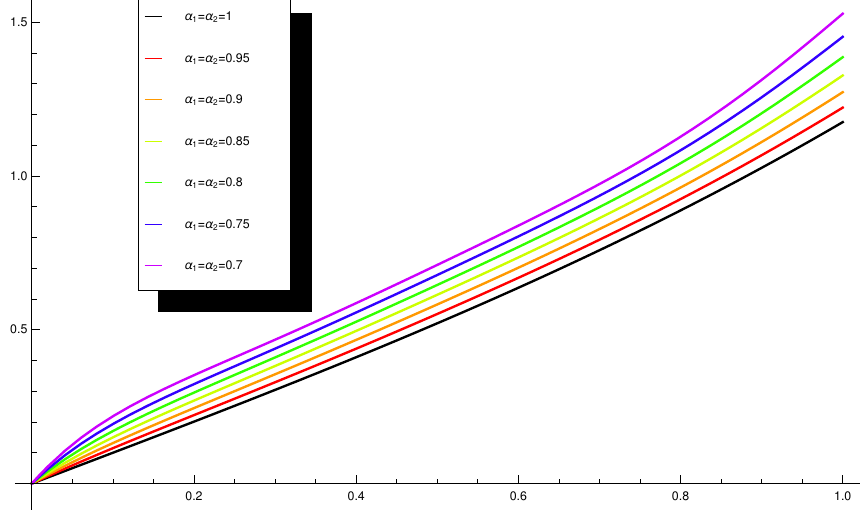
Figure 3. Approximate solutions x 1 of (18) for several values of α 1 and α 2